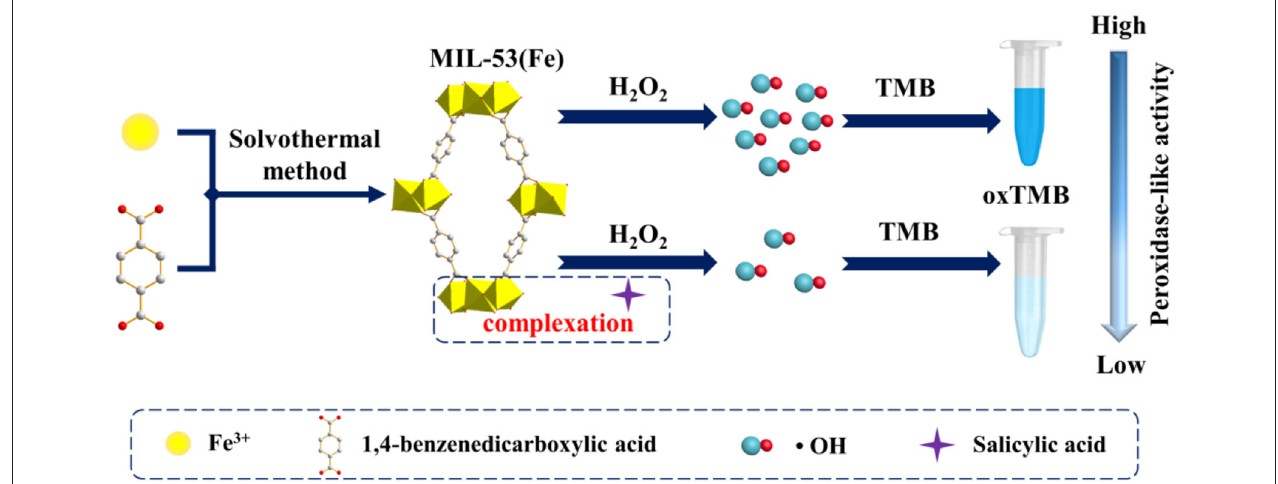
FIGURE 1 | Schematic illustration of MIL-53(Fe) synthesis and colorimetric detection of SA based on the MIL-53(Fe) nanozyme.